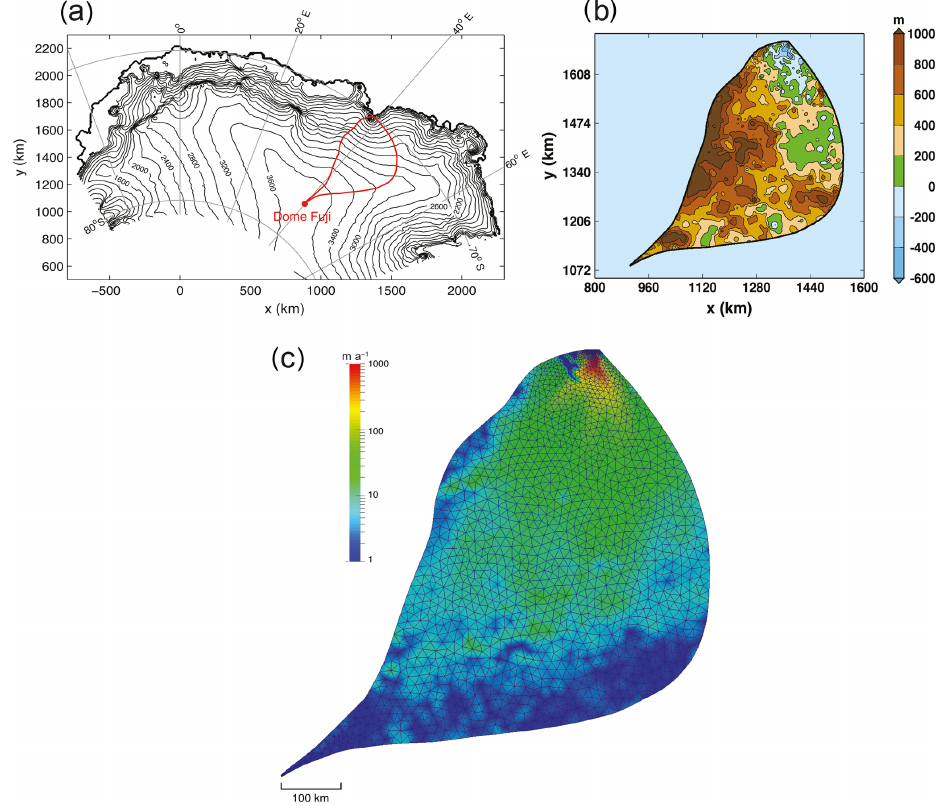
Figure 1. Shirase drainage basin: (a) location in East Antarctica. The two red lines delimit the drainage basin. They originate at Dome Fuji and follow the steepest descent of the free surface, hence approximately representing flow lines. Underlying map generated with data by Bamber et al. (2009). (b) Bed topography by Fretwell et al. (2013). (c) Surface velocities by Rignot et al. (2011), finite element mesh of the computational domain superimposed. Note the mesh refinement towards the grounding